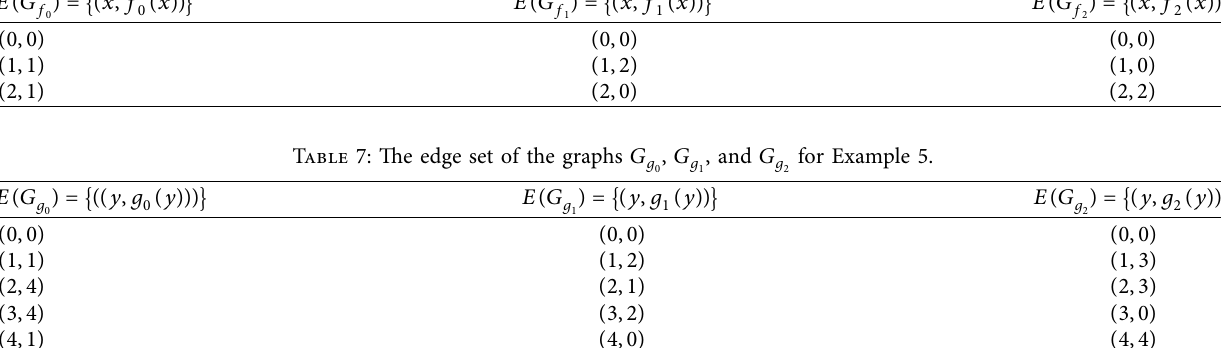
Table 6: Te edge set of the graphs G